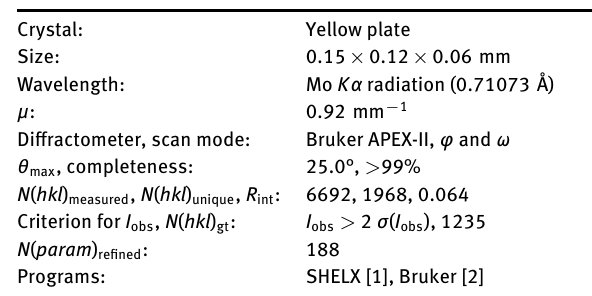
Table 1: Data collection and handling.